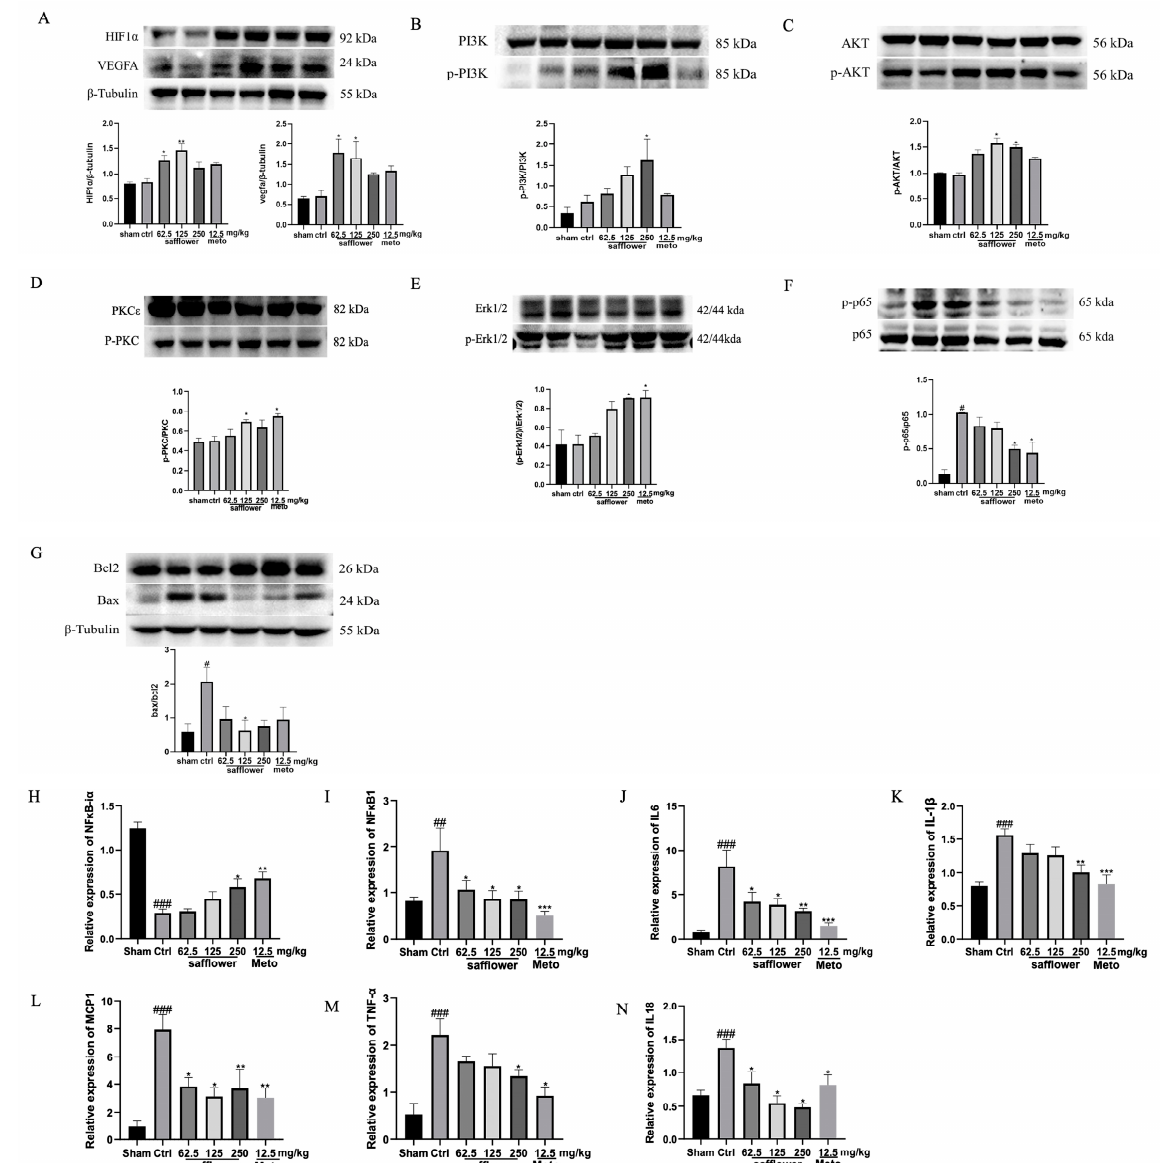
Figure 7. The protein expression of HIF1 α ( A ) , VEGFA ( A ), p-PI3K/PI3K ( B ), p-AKT/AKT ( C ), p-PKC/PKC ( D ), p-ERK1/2/ERK1/2 ( E ), p-NFkB-p65/NFkB-p65 ( F ), and BAX/BCL2 ( G ) in the hearts of MIR-injured mice using Western blotting analysis ( n = 3 per group). The mRNA expressions of inflammation-related factors in safflower treatment of MIR injury are shown ( H – N ). Values are means ± SEM, # p < 0.05, ## p < 0.01, ### p < 0.001 vs. sham, respectively; * p < 0.05, ** p < 0.01, *** p < 0.001 vs. control, respectively; one-way ANOVA.